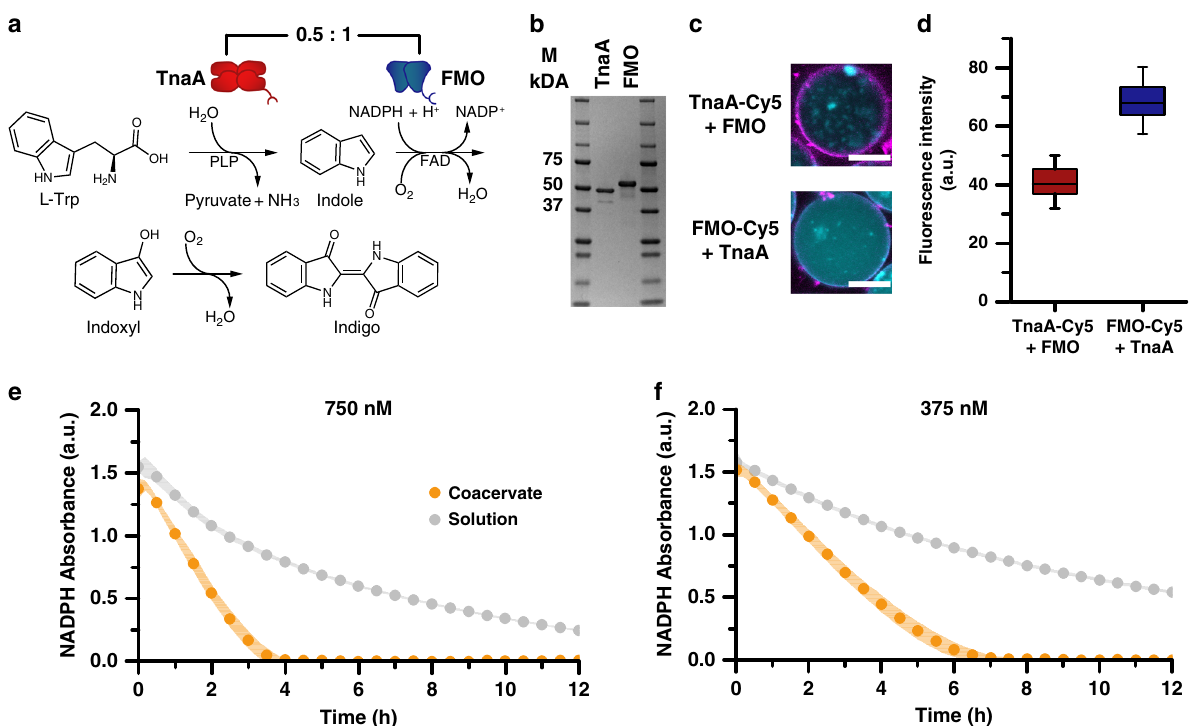
Fig. 4 Increased enzymatic activity by controlled loading of a synthetic two-enzyme cascade. a Schematic overview of the reaction scheme to produce Indigo from L -Trp by TnaA and FMO. b Analysis of the puri fi ed enzyme variants by SDS-PAGE gel electrophoresis. Left to right: marker (M), TnaA, FMO, M. c Confocal micrographs of coacervates loaded with 100 nM Sulfo-Cy5-NHS-labeled TnaA + 200 nM unlabeled FMO (top) or 200 nM FMO + 100 nM unlabeled TnaA (bottom). Membrane stained with Nile red (purple), scale bar: 10 µ m. Uncropped images are to be found in Supplementary Fig. 18. d Box plot analysis of the loading of fl uorescently labeled enzymes inside the coacervates. For all cases, n > 50. e , f NADPH consumption measured by the absorbance at 340 nm. 1 mM L -Trp and 0.5 mM NADPH was added prior to the measurement. Orange circles represent enzymes inside the coacervates, gray circles show enzymes in solution. Three individual batches of coacervates were made for each condition, the standard deviation of three individual measurements is represented by the shaded area. For clarity of the graph, only 1/3rd of all collected data points are shown. e 250 nM TnaA + 500 nM FMO. f 125 nM TnaA + 250 nM